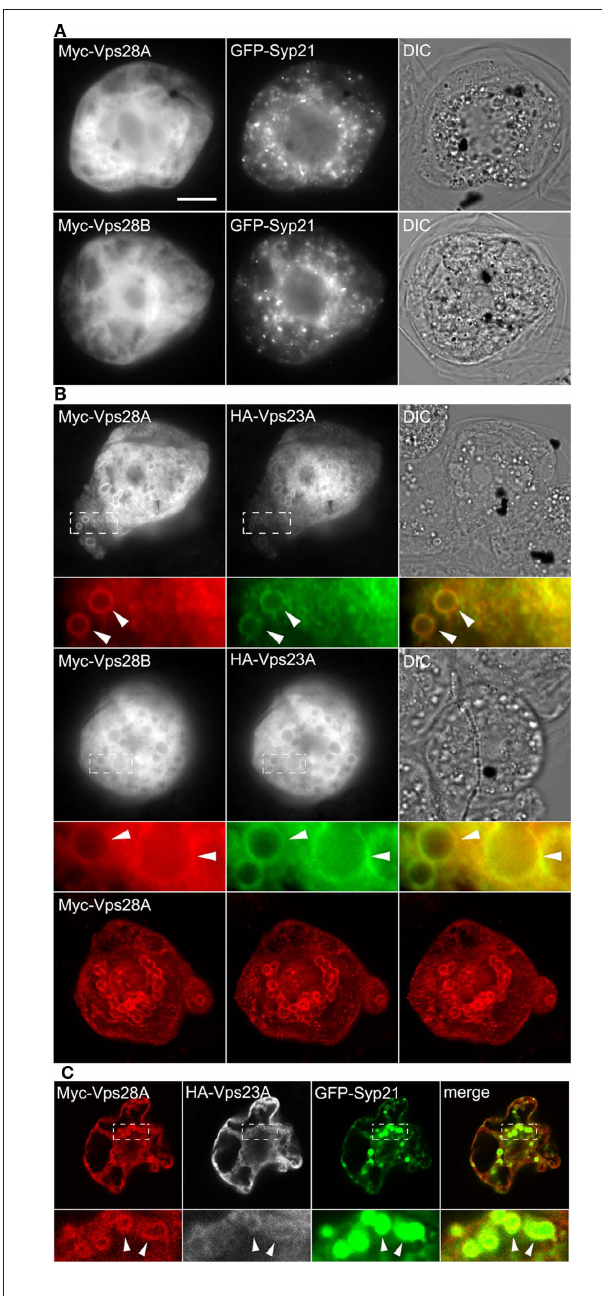
FIGuRE 4 | Subcellular localization of Vps28A and Vps28B and co- expression of Vps28A or Vps28B with Vps23A. BY‑2 cells were co‑ transformed the indicated gene constructs and then cells were processed, imaged, and analyzed either by (A,B) epifluorescence microscopy or [ (B) bottom row and (C) ] CLSM as described in the legend of Figure 2 . The yellow color in the corresponding merged images indicates co‑localization between co‑expressed proteins; white arrowheads also indicate obvious protein co‑localization in the large, ring‑like MVB‑related structures. Note that the CLSM images presented in [ (B) bottom row] are three different rotations (i.e., left ∼− 15 ° , center, and right ∼+ 15 ° ) obtained from the same 3D projection (full z‑series) of immunostained Myc‑Vps28A in an Myc‑Vps28A and HA‑Vps23A co‑transformed cell; refer also to Figure S4 in Supplementary Material for the corresponding movie. The CLSM images of the triple‑transformed cell in (C) are single z‑sections. Bar = 10 μm.